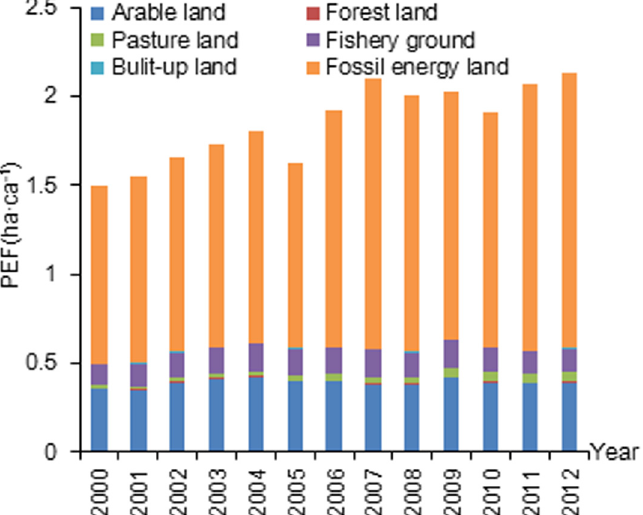
Fig 2. PEF of six biologically productive land types between 2000 and 2012 in Xiamen